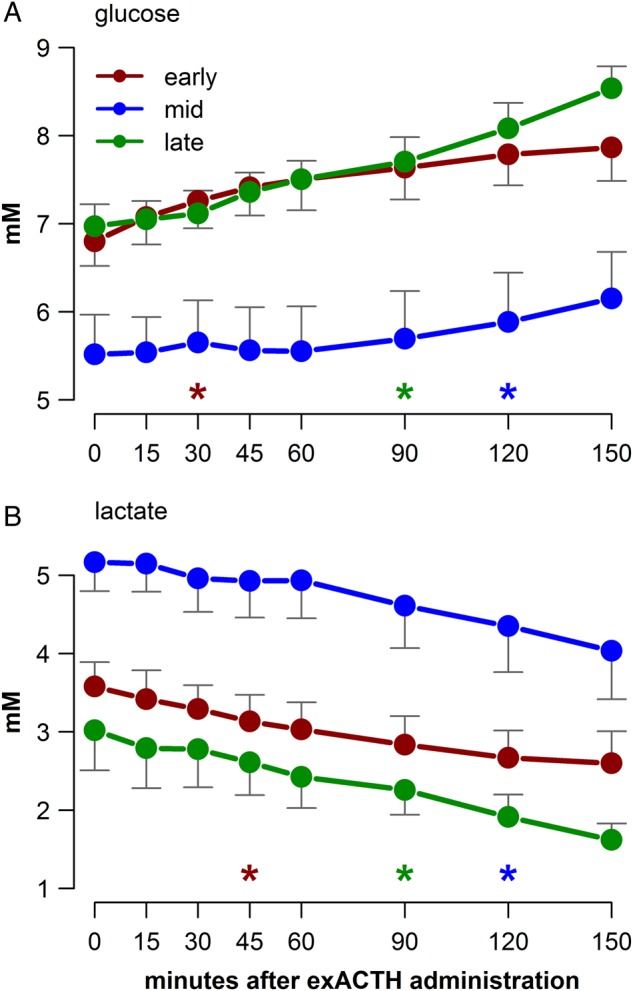
The responses of glucose (A) and lactate (B) to exACTH administration for each of the three study states: early, middle and late moulting. Initial values are shown at time zero. Coloured asterisks indicate that the hormone value at that time point and all subsequent time points differs significantly from the initial hormone value (Dunnett's test, P < 0.05). Error bars represent SEM at each sampling time.